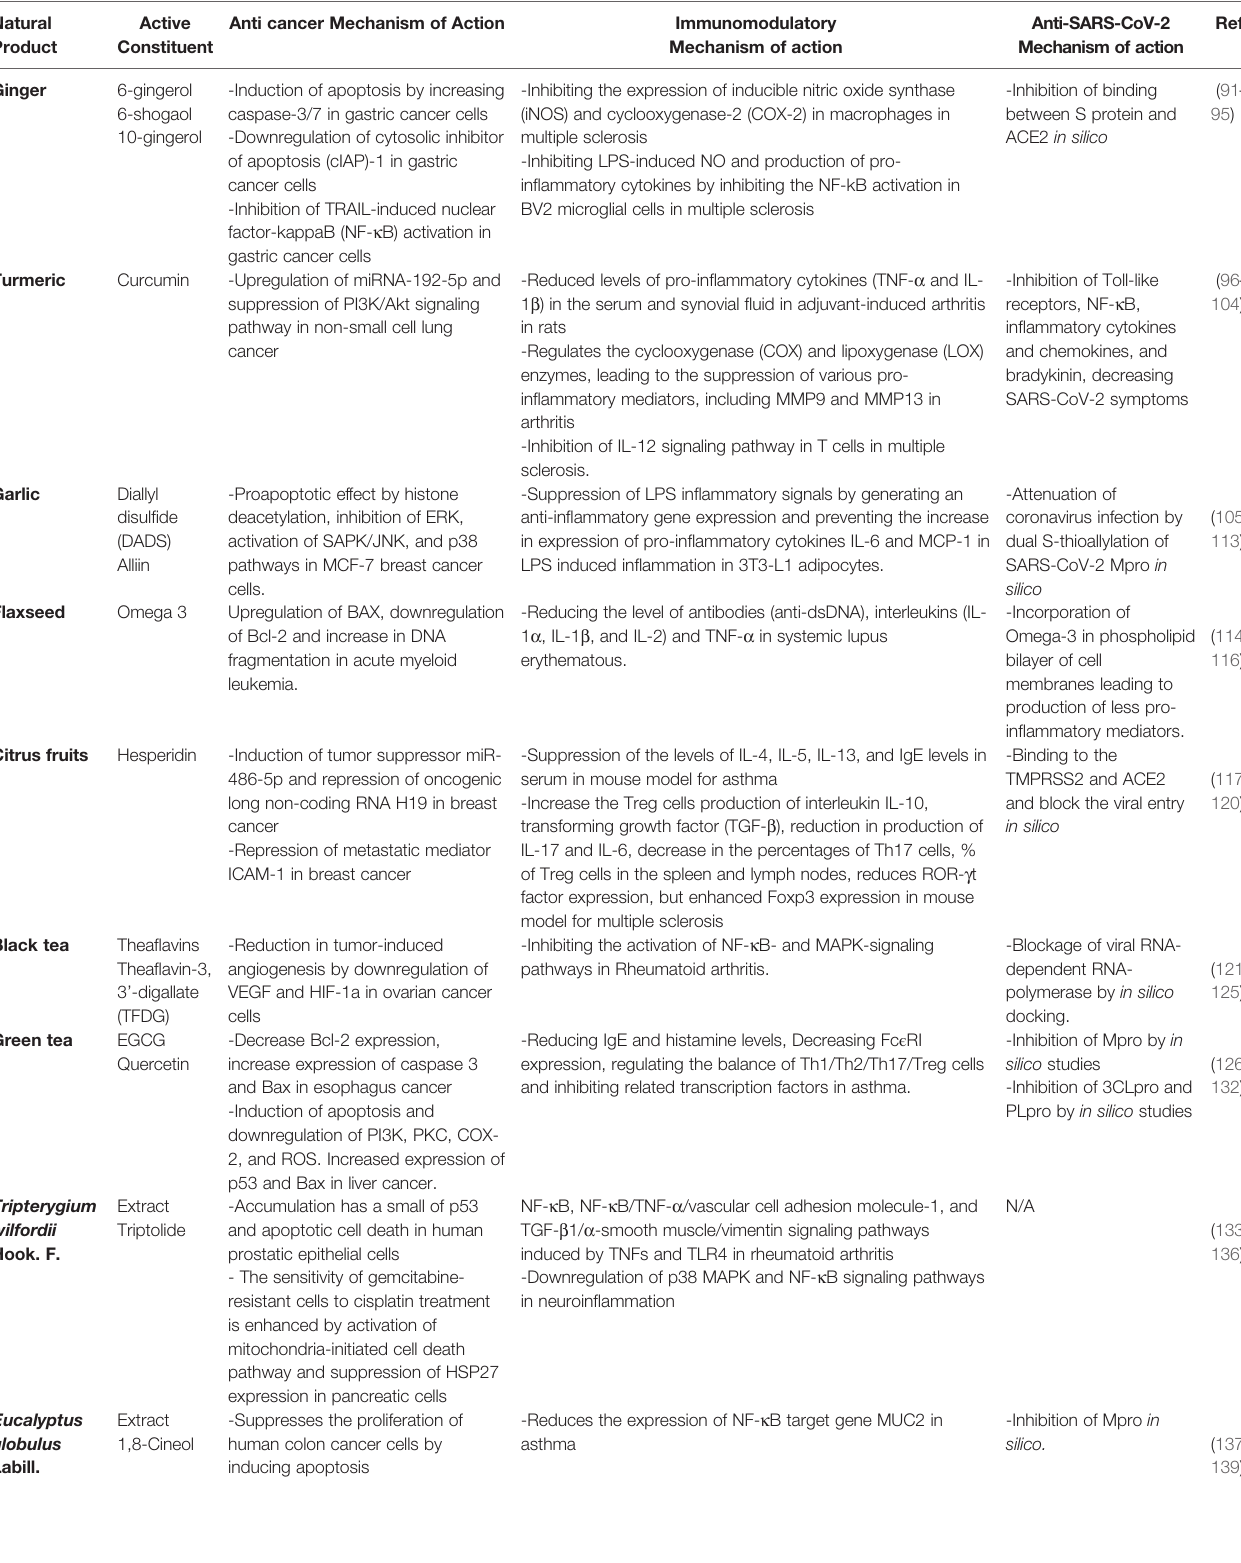
TABLE 2 | Tri-acting (anticancer, immunomodulatory, and anti-SARS-CoV-2) natural products. Natural